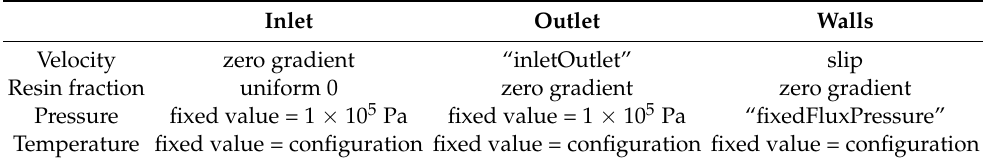
Table 1. Start and boundary